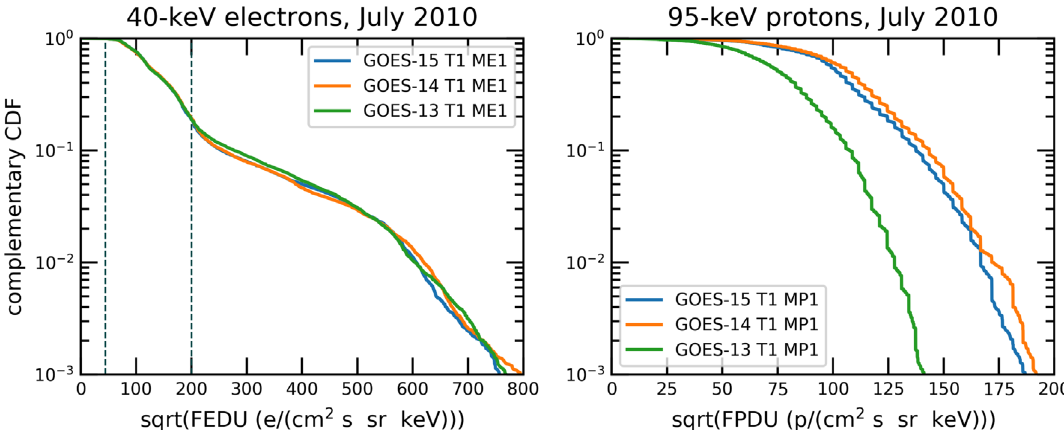
Fig. 4. Complementary CDFs (1-CDF) of GOES 13-15 Telescope 1 40-keV electrons (ME1) and 95-keV protons (MP1) during July 2010, plotted versus the square root of fl ux. The vertical dashed lines on the left-hand plot are discussed in the